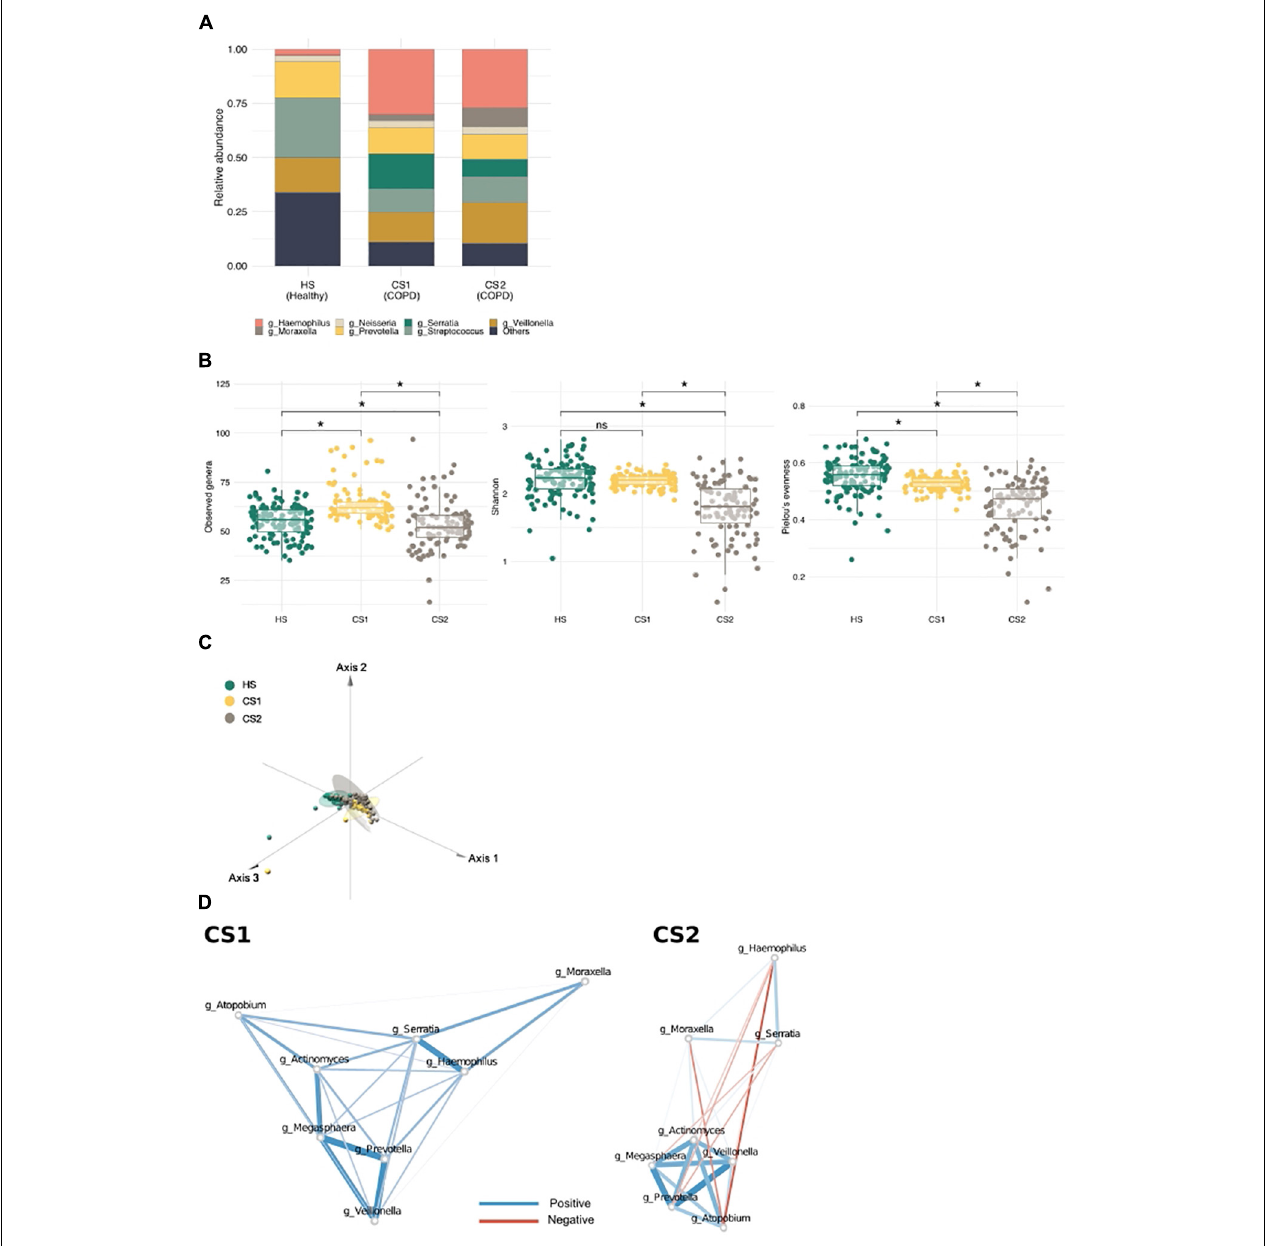
FIGURE 4 | Metacommunities in the chronic obstructive pulmonary disease (COPD) cohort (Haldar et al.). (A) A stack bar graph showing the most abundant genera in each metacommunity. (B) Metacommunity diversity at the genus level. * q < 0.1. (C) A principal coordinate analysis (PCoA) plot showing the distribution of functional features between metacommunities. (D) The interaction of inflammatory bacteria with COPD-related taxa in CS metacommunities. Red and blue edges indicate negative and positive correlations, respectively. Edge width reflects the strength of the